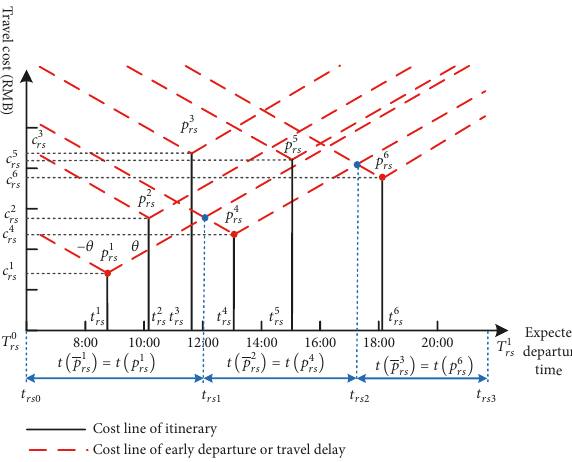
Figure 1: Preferable itineraries and expected departure